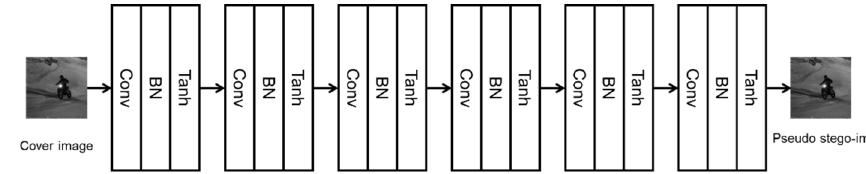
Figure 3. Structure of the CNN generator.